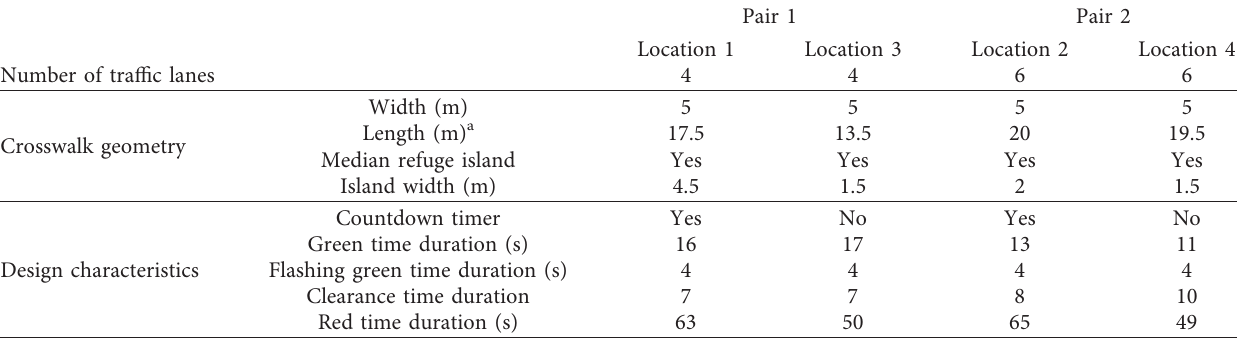
Table 1: Summary of key characteristics of study locations.